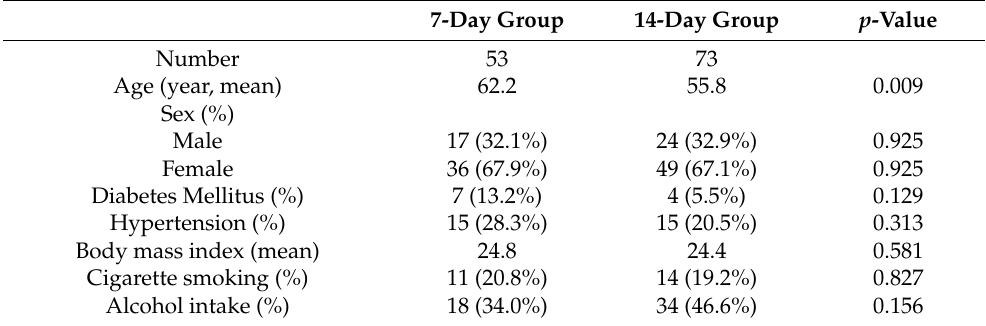
Table 1. Basic characteristics.